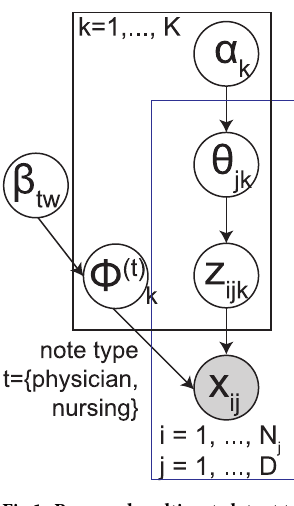
Fig 1. Proposed multi-note latent topic